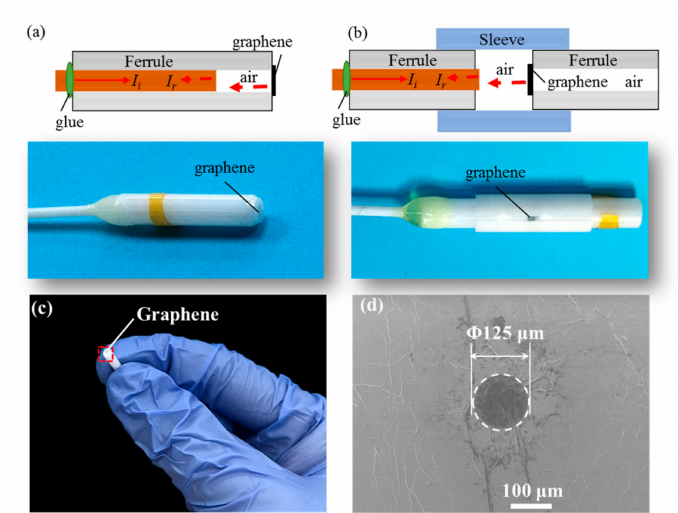
Figure 1. Schematic diagram and physical picture of the F-P sensor samples with ( a ) sealed and ( b ) open cavities (not to scale); ( c ) ~13-layer graphene-covered ZrO 2 ferrule; and ( d ) the magnification SEM image of the rectangular area shown in ( c